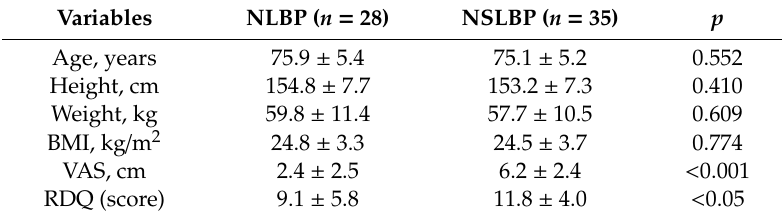
Table 1. Demographic characteristics and functional outcome of the patients.